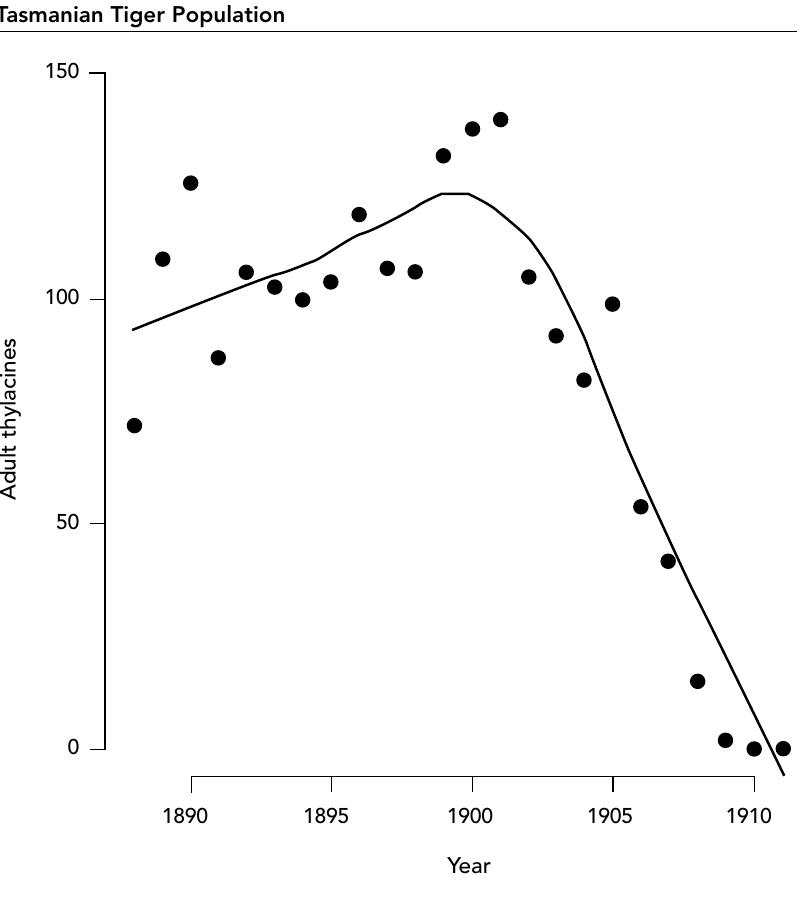
Figure 3. Population of Tasmanian tigers (Thylacines) before their complete extinction in the 1930s (McCallum